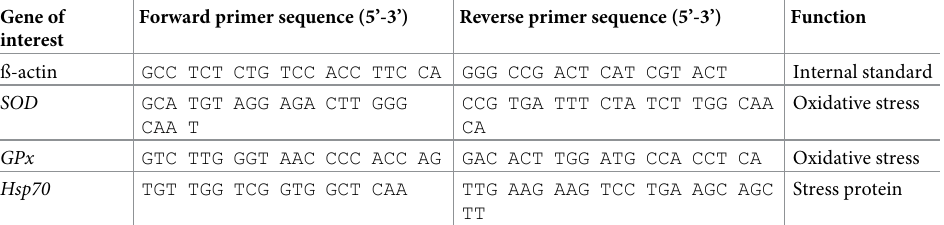
Table 1. Primer sequence for the expression study of selected genes in yellow perch, P . flavescens